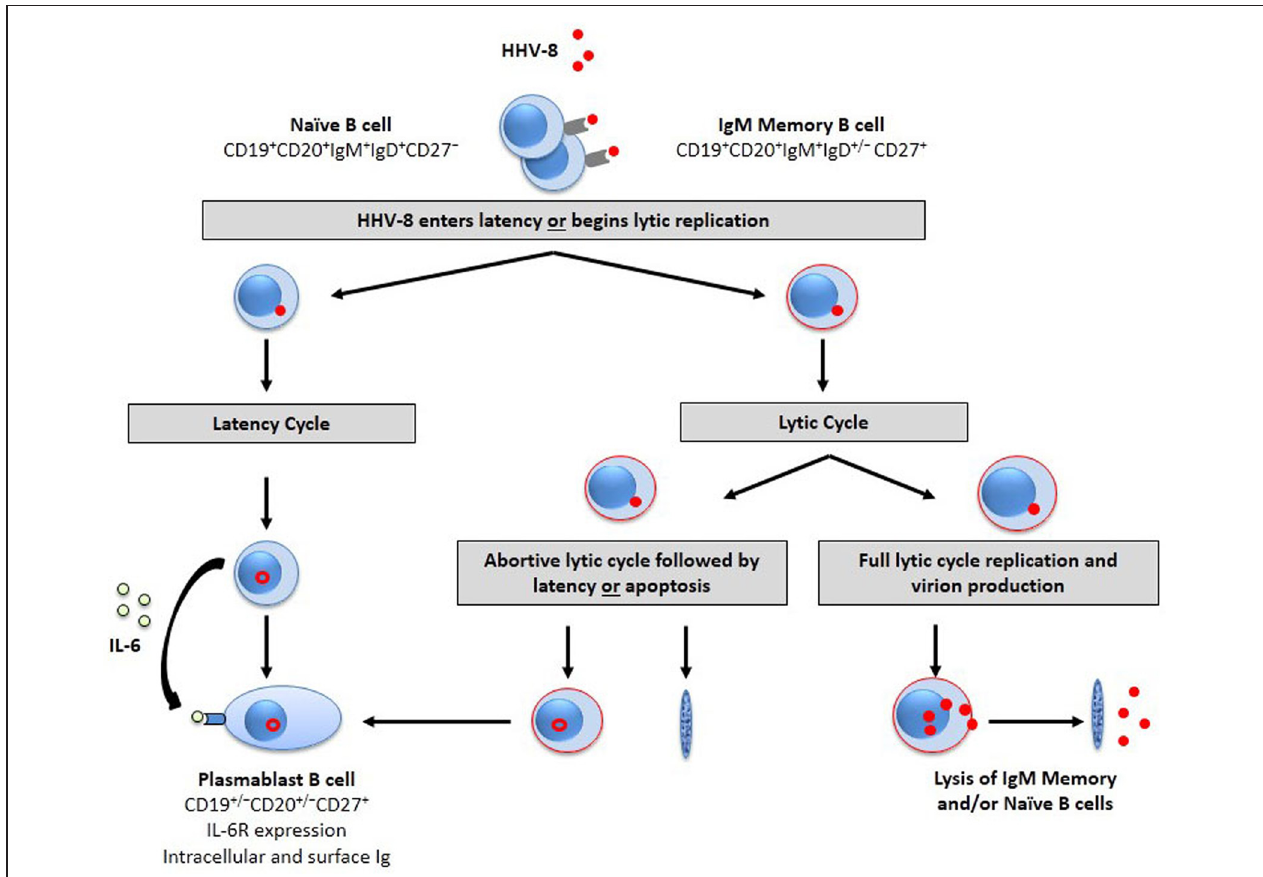
FIGURE 1 | HHV-8 targets B cell subpopulations for infection. The B cell target for HHV-8 infection is unknown. However,